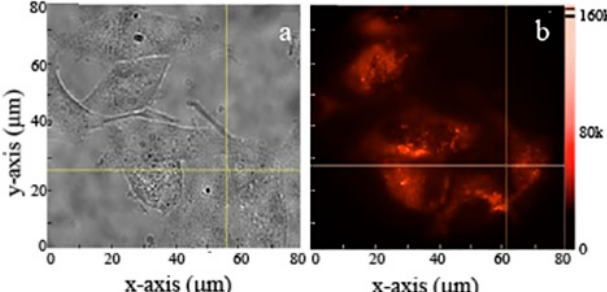
Figure 7. ( a ) Brightfield and ( b ) widefield fluorescence image of human keratinocytes cells cultured with commercial MgO NPs. Excitation power was 300 mW at the back of the objective distributed over a widefield scan area of 80 × 80 µ m 2 . This provides an average power of 45 µ W / µ m 2 on the sample’s surface.